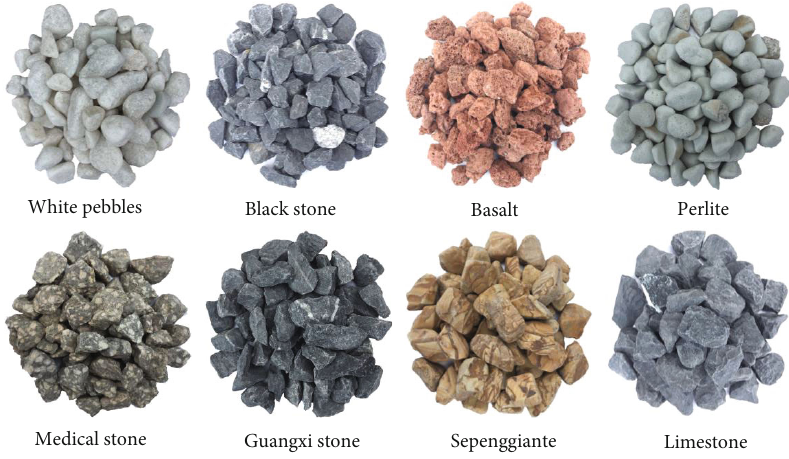
Figure 1: Eight kinds of materials were used in the